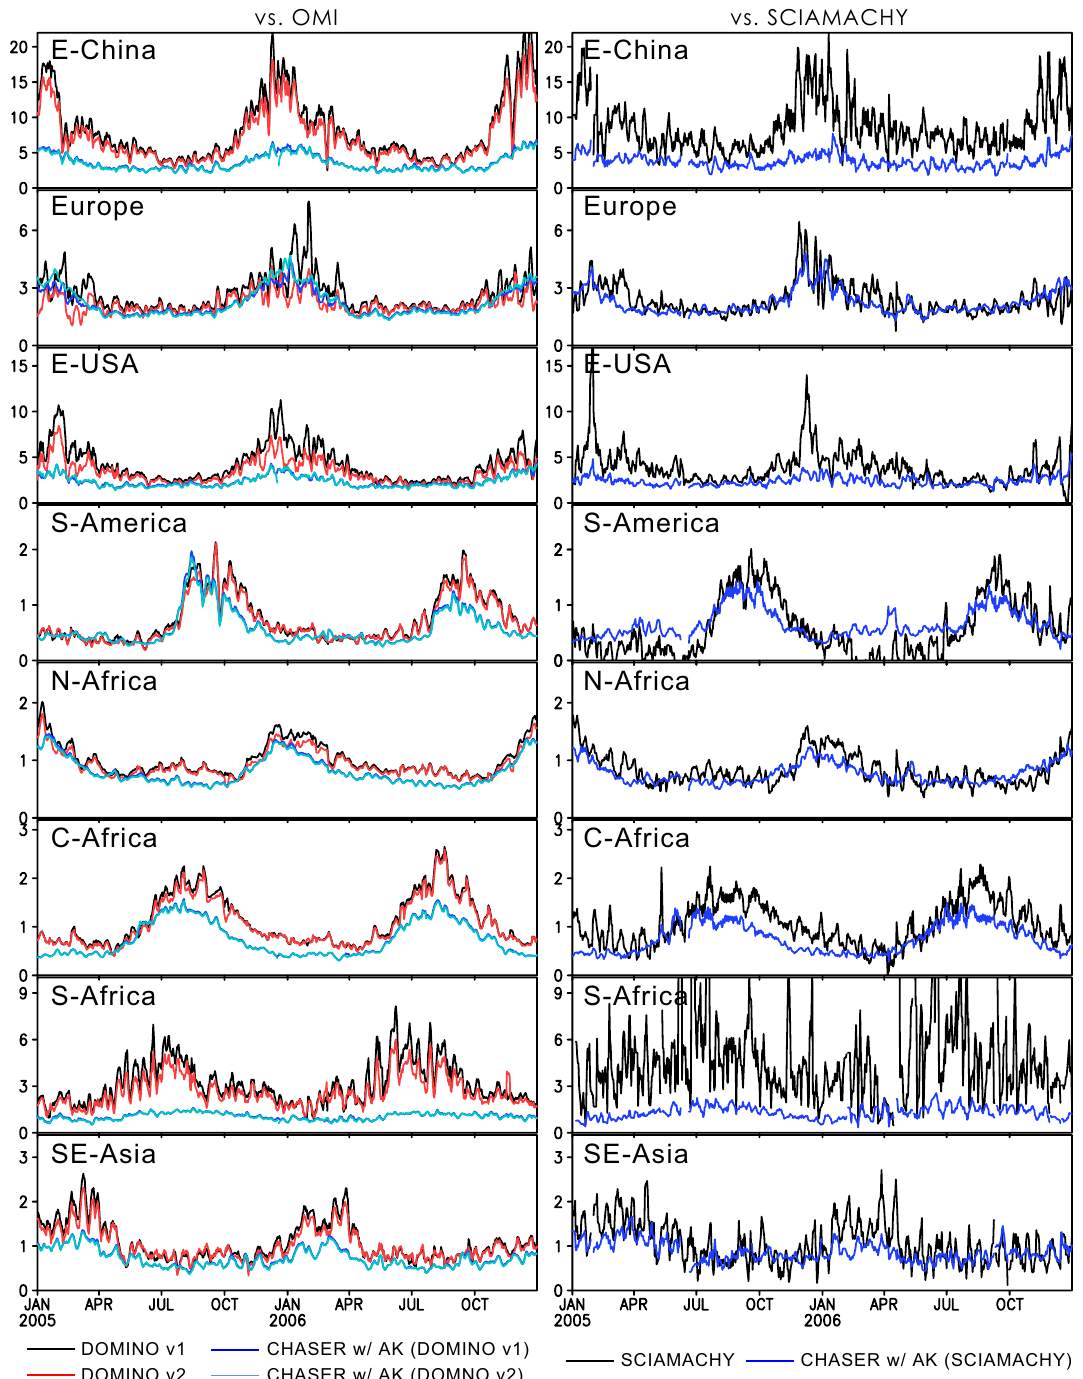
Fig. 3. Seasonal variations of the regional mean tropospheric NO 2 columns (in 10 15 molec . cm − 2 ) for eastern China (110–123 ◦ E, 30– 40 ◦ N, top panels), Europe (10 ◦ W–30 ◦ E, 35–60 ◦ N, second-top panels), the eastern United States (95–71 ◦ W, 32–43 ◦ N, third-top panels), South America (70–50 ◦ W, 20 ◦ S–Equator, fourth-top panels), northern Africa (20 ◦ W–40 ◦ E, Equator–20 ◦ N, fifth-top panels), central Africa (10–40 ◦ E, 20 ◦ S–Equator, sixth-top panels), southern Africa (26–31 ◦ E, 28–23 ◦ S, seventh-top panels), and Southeast Asia (96–105 ◦ E, 10– 20 ◦ N, bottom panels) for 2005–2006. Tropospheric NO 2 columns obtained from DOMINO v2 (red lines in left panels), DOMINO v1 (black lines in left panels), the SCIAMACHY retrieval (black lines in right panels), and the CHASER simulation with the AK (blue and light blue lines) are plotted for local time 13:30 (left) and 10:00 (right). A 4-day running-mean was applied to the